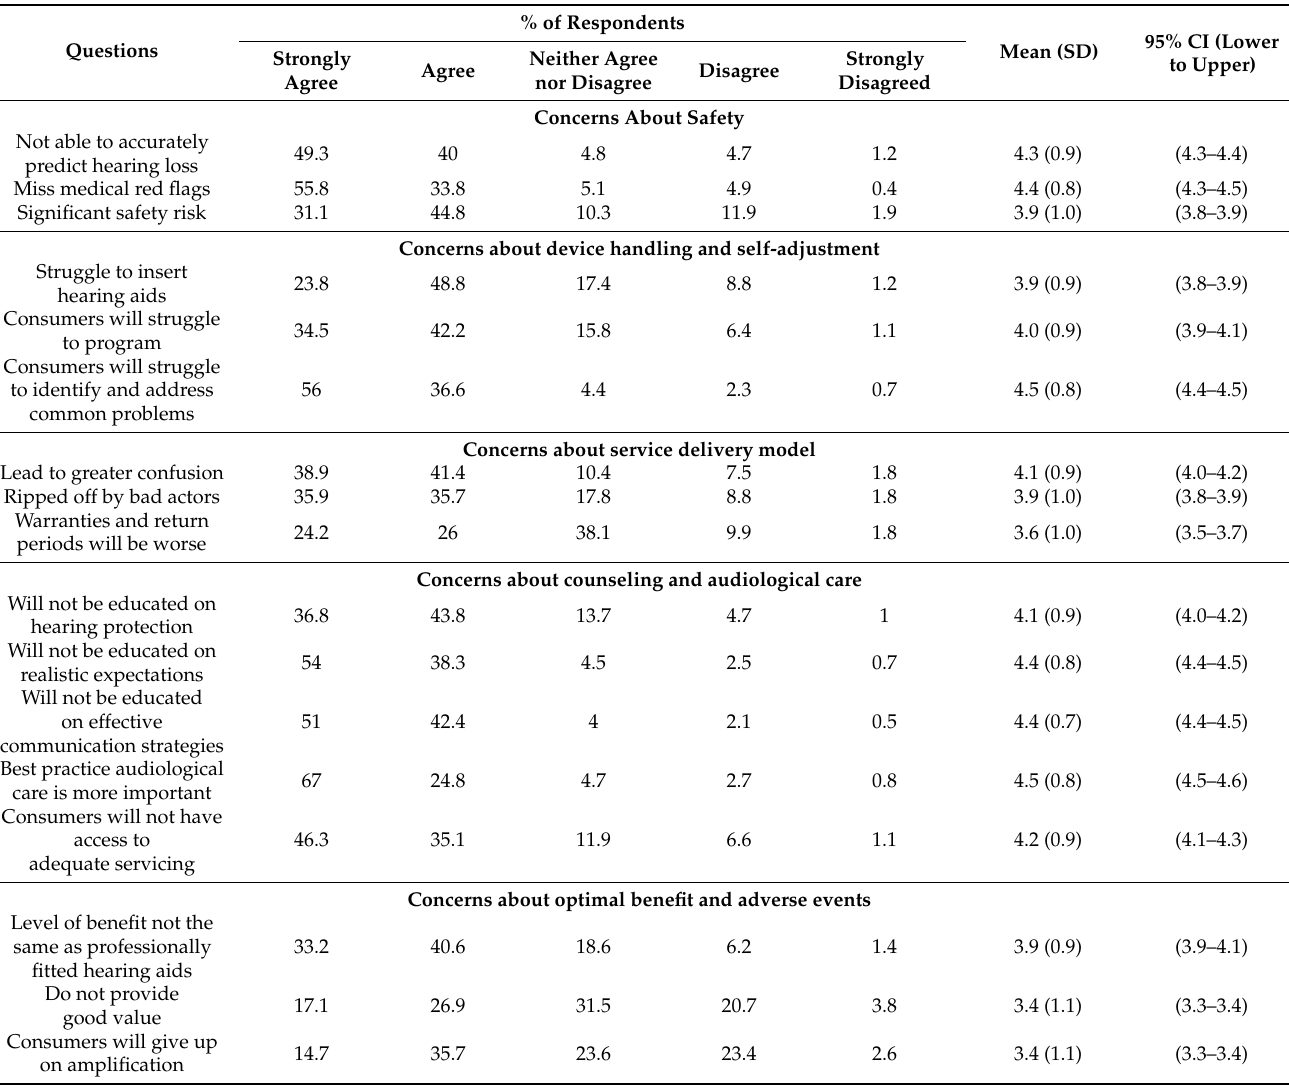
Table 2. Hearing healthcare professionals (HHPs) concerns towards over-the-counter (OTC) hearing